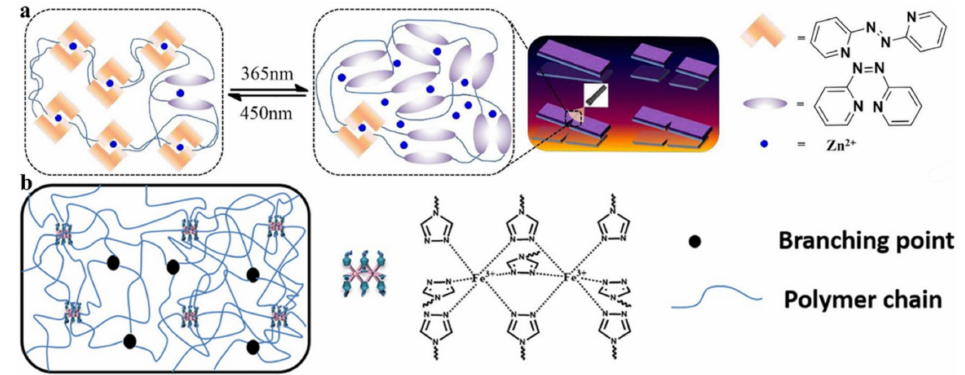
Figure 22. ( a ) Schematic diagram of the light-healing process. Reproduced from [154] with permission from Elsevier. ( b ) Preparation of SHP with Fe–triazole interactions. Reproduced from [155] with permission from John Wiley and